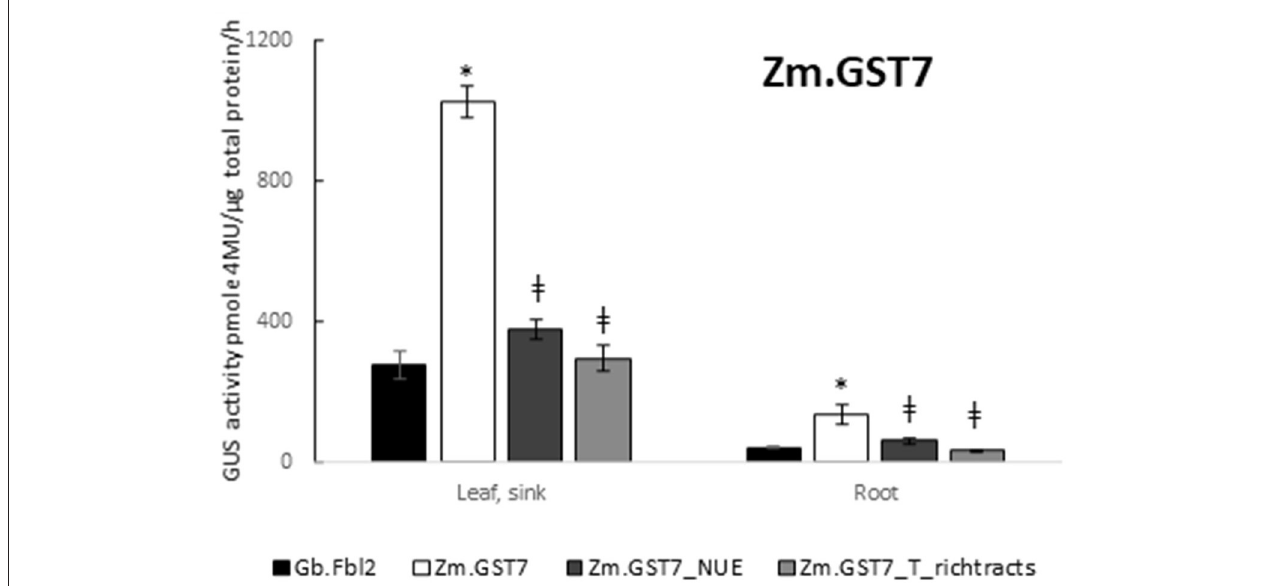
FIGURE 7 | GST7 enables effective expression that is dependent on functional polyadenylation and cleavage signals. Expression of GUS reporter genes with Zm.GST7 and its NUE polyadenylation signal and T-rich tract cleavage site variants were compared with Gb.Fbl_3 ′ UTR in the same expression cassette context with At.GSP571 and At.Cyco_intron. Zm.GST7_NUE and Zm.GST7_T-rich_tracts 3 ′ UTR variants were generated by introducing transversions in the relevant motifs. GUS reporter gene activity was performed on leaf and root tissues from transgenic soybean plants at the V3 stage. GUS enzyme activity on MUG substrate was normalized to total protein and reported as pmol 4-MU/ µ g total protein/h. At least 12 independent transgenic events were analyzed, and the data are reported as the mean with standard error. *Indicates a statistically significant difference between Zm.GST7 and Gb.Fbl2, whereas 6= indicates a statistically significant difference between original Zm.GST7 and mutant variant when compared in the same tissue type with p -value threshold corrections to control for false discovery < 0.05 in multiple